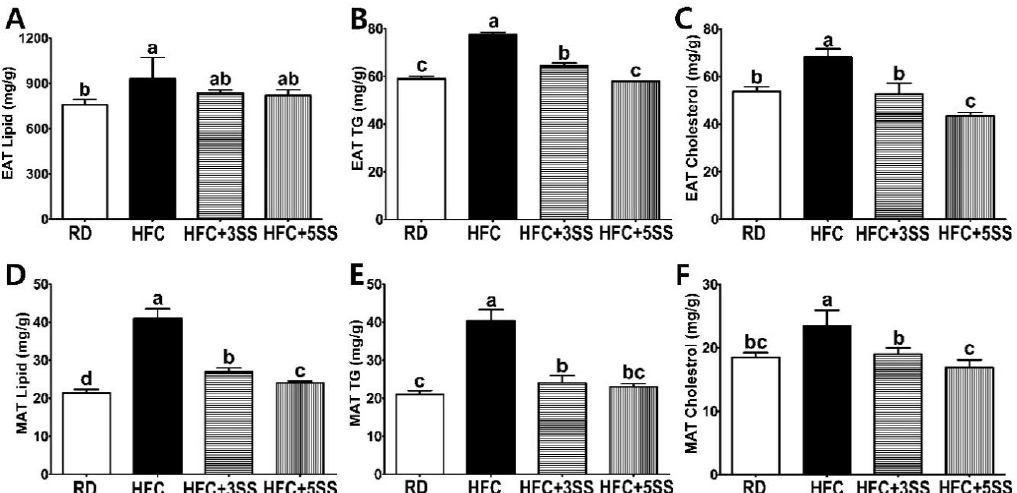
Figure 6. Effect of S. sieboldii Miq. root powder (SS) on adipocyte lipid accumulation. Experimental rats were fed a regular diet (RD) or a high-fat and high-cholesterol (HFC) diet with or without Stachys sieboldii Miq. root powder (SS; 3 or 5%) supplementation for 6 weeks. ( A , D ) Lipid, ( B , E ) triglyceride and ( C , F ) cholesterol were measured from the epididymal adipose tissue (EAT) and mesenteric adipose tissue (MAT) and expressed as mg/g. RD, regular diet; HFC, high-fat and high-cholesterol diet; HFC + 3SS, High-fat and high-cholesterol diet + 3% of Stachys sieboldii Miq. root powder; HFC + 5SS, high-fat/high-cholesterol diet + 5% of Stachys sieboldii Miq. root powder. Values are means ± standard deviation, n = 8. Data were analyzed using one-way ANOVA followed by Tukey’s post hoc test. Means labeled without a common letter differ significantly, p < 0.05.